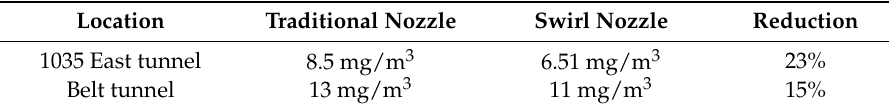
Table 1. Swirl nozzle spray dust effect in coal